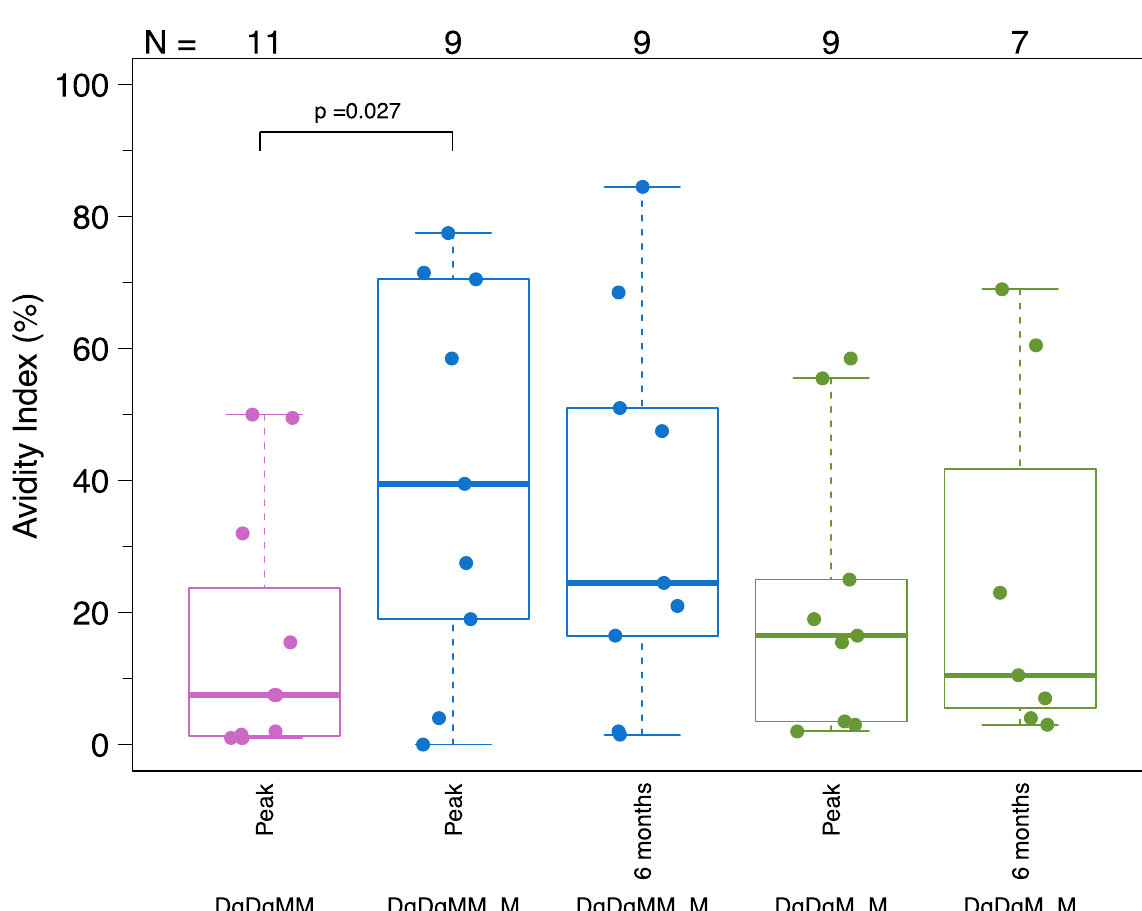
Fig 5. Antibody avidity. Distributionof bindingantibody avidity responsemagnitude among vaccine recipients at two weeks and 6 months after the 2nd and 3rd MVA in the DgDgM_Mand DgDgMM_Mgroups. DgDgM_Mrefers to immune responsesafter the last MVA in the DgDgM_Mgroup; DgDgMMand DgDgMM_Mrefer to immune responses after the 2nd and 3rd MVA in DgDgMM_M group, respectively.Avidity Index (AI) was calculatedfor the ID epitopetetramer for those with a positive bindingresponseto the ID epitopetetramer and only for samples not saturated(MFI < 23000). Wilcoxon signedrank tests were used to compareAI values among positive responders.